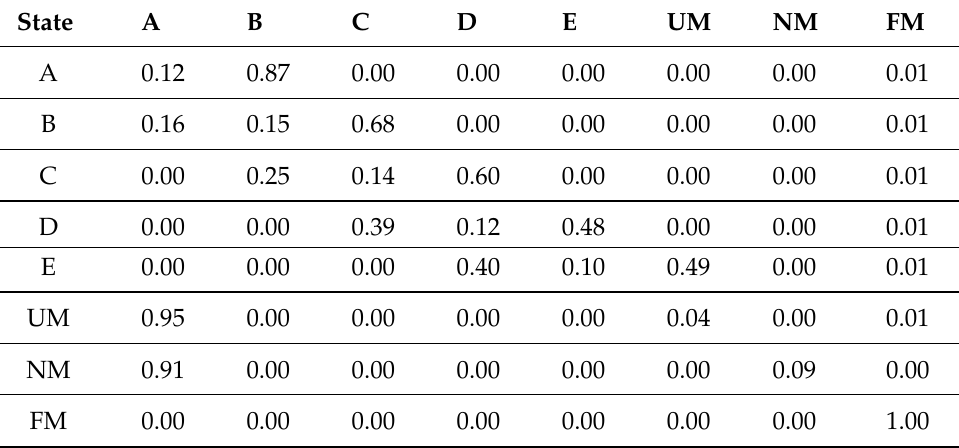
Table 3. Bayesian Network Transition Probability